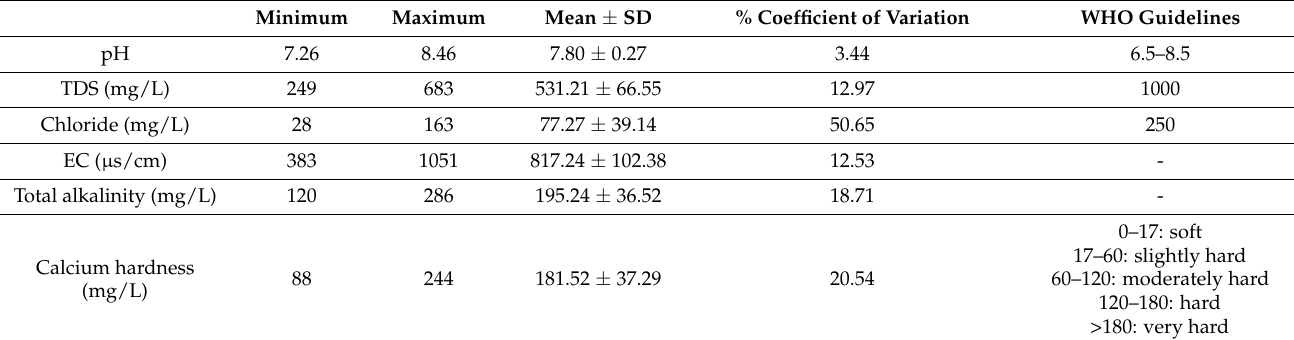
Table 3. Physicochemical parameters of collected water samples.